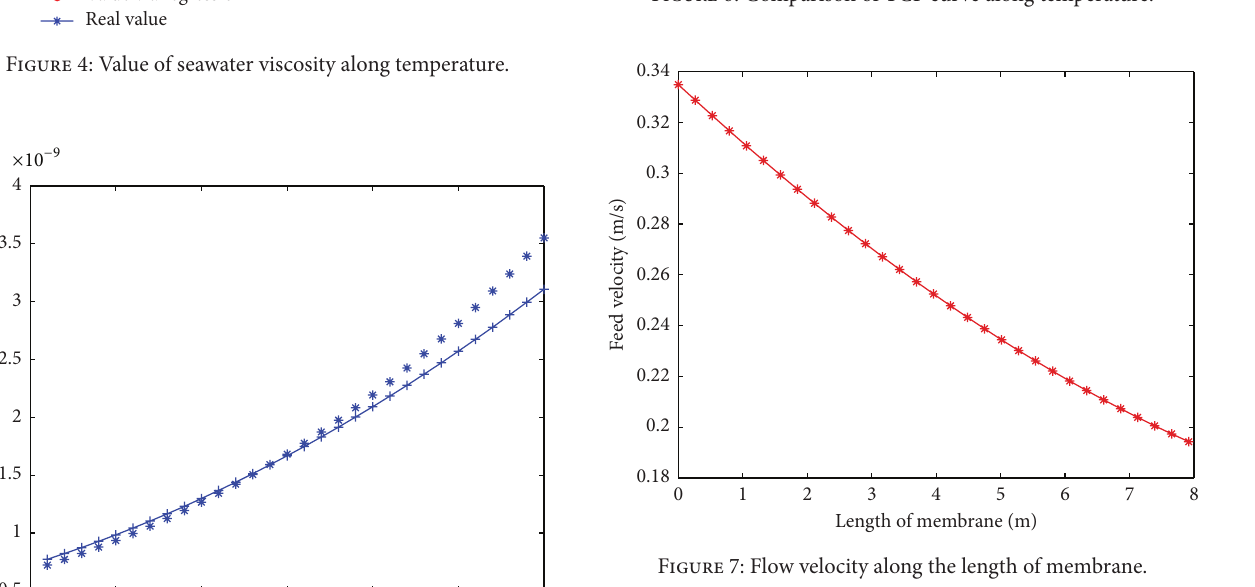
Figure 6: Comparison of TCF curve along temperature.